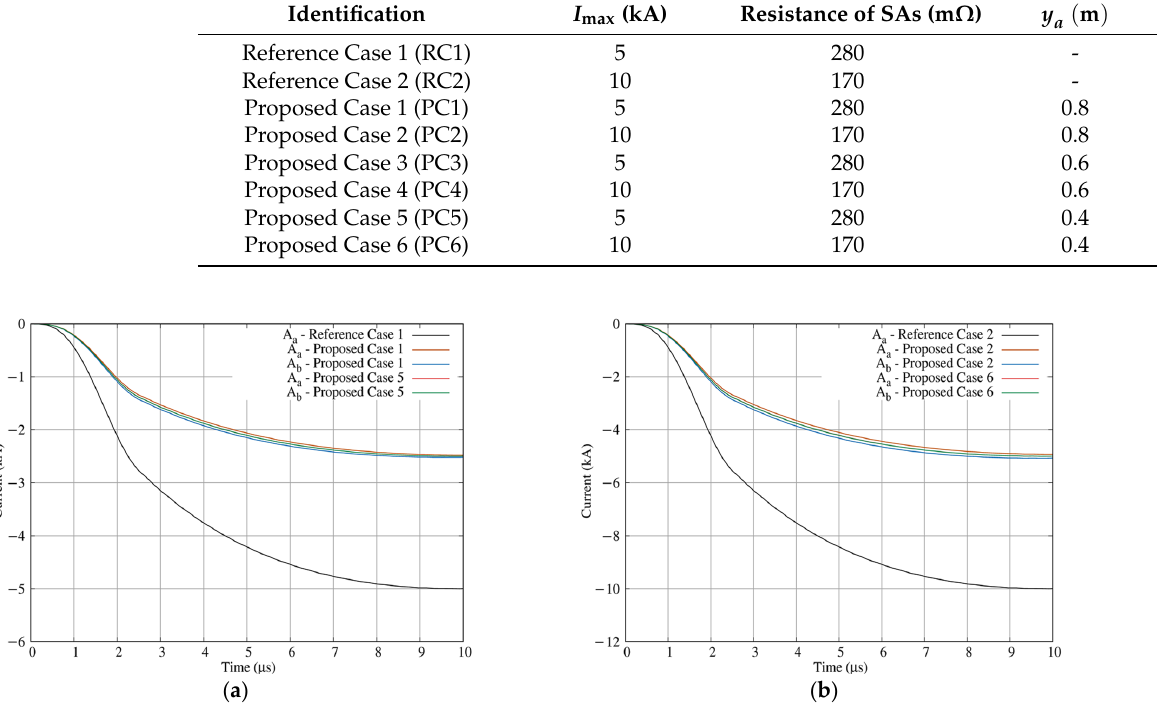
Figure 10. The calculated surge arresters’ currents for ( a ) I max = 5 kA and ( b ) I max = 10 kA.